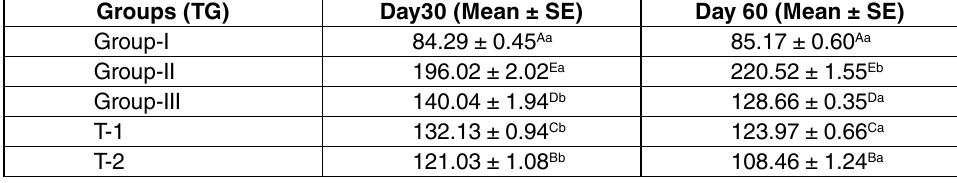
table 7. The mean±SE serum triglycerides (mg/dl) values in different treatment groups.